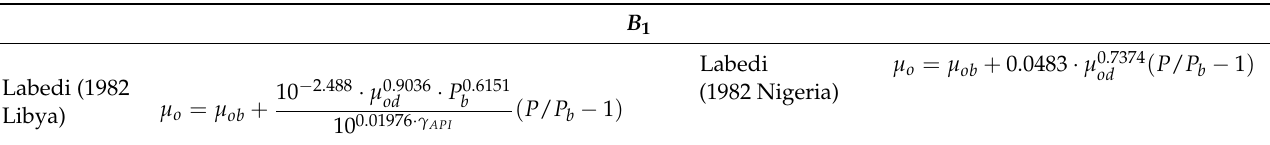
Table 3. Correlations in cluster B 1